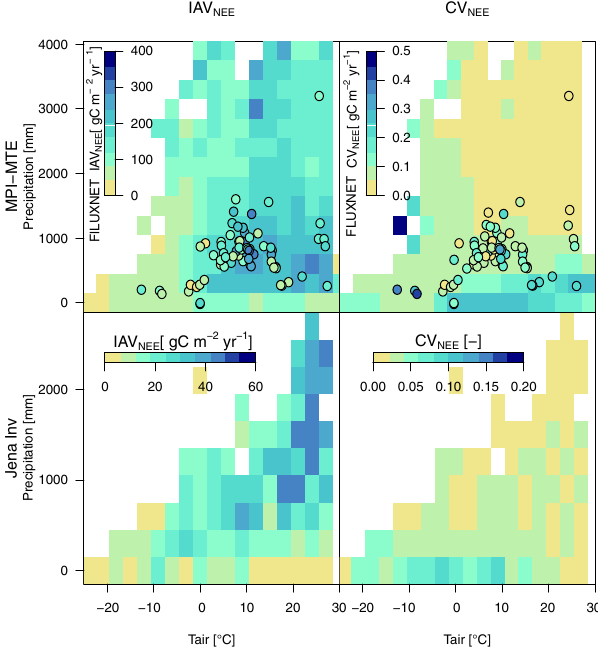
Figure 2. IAV NEE (left panels) and normalized IAV NEE (CV NEE , right panels) plotted in a temperature–precipitation space for MPI- MTE (top panels) and the Jena Inversion (bottom panels). Dots represent FLUXNET site values. MPI-MTE and the Jena Inversion both refer to the scales of the bottom panels.